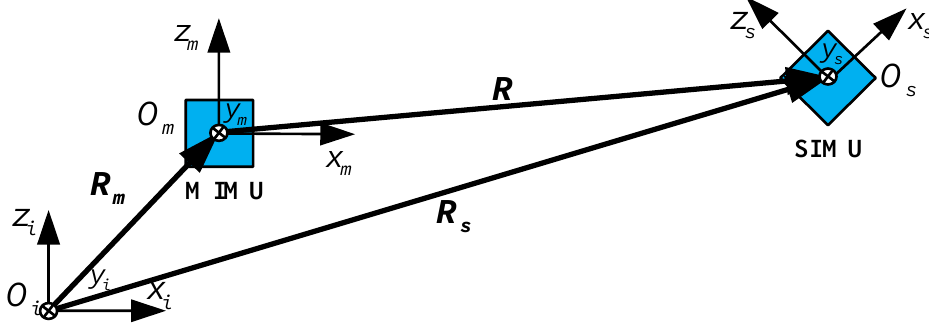
Figure 4. Relative position and attitude relationship between MIMU and SIMU.